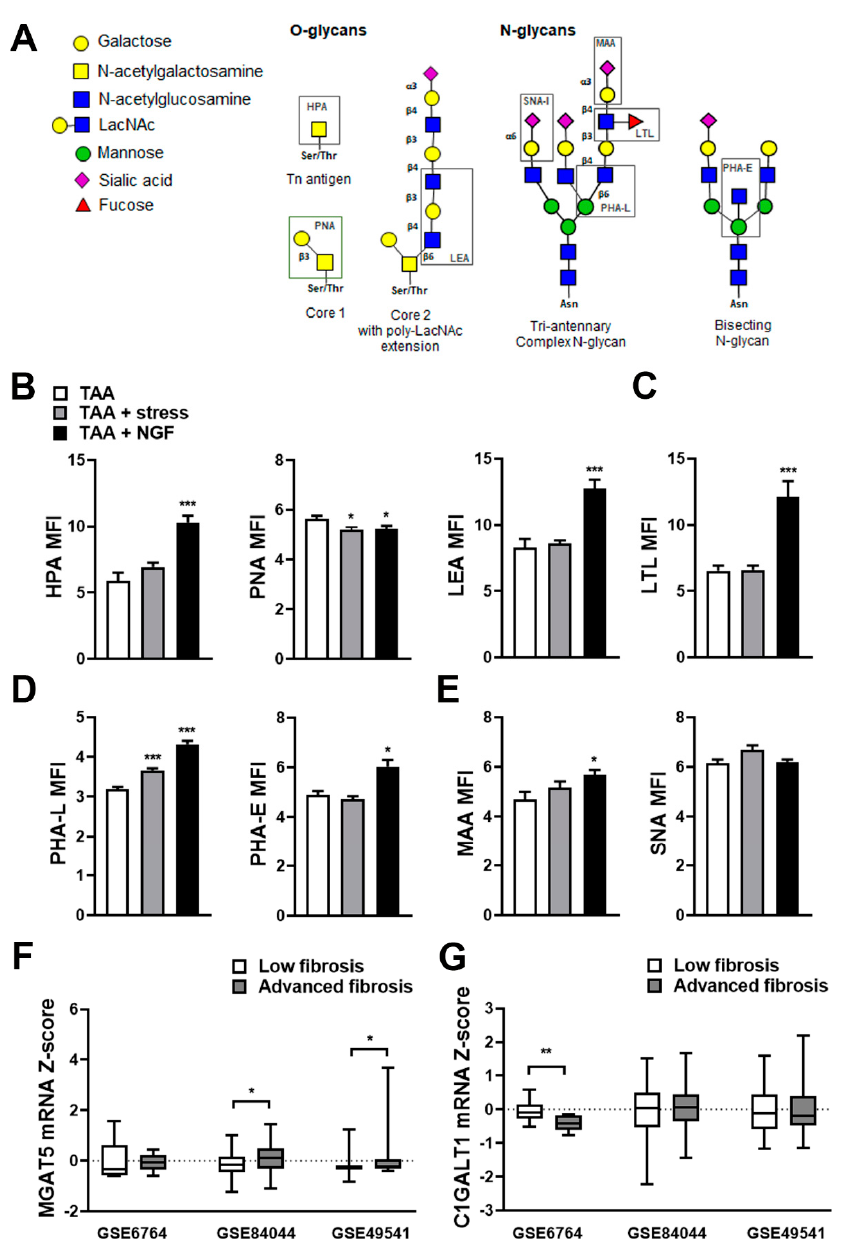
Figure 5. ( A ) For an analysis of the glycophenotype, lectins were used to detect different types of glycosylation. O-glycan structures were recognized by Helix pomatia agglutinin (HPA; Tn-antigen) and Arachis hypogaea lectin (PNA; core 1). Lycopersicon esculentum lectin (LEA) recognizes polyLAcNac sequences. Phaseolus vulgaris lectin (PHA-L) recognizes β 1-6GlcNAc-branched complex N-glycans and Phaseolus vulgaris lectin E subunit (PHA-E) identifies glycans with a bisecting modification. Fucosylation was determined by Lotus tetragonolobus lectin (LTL) and finally sialyation was determined using the Maackia amurensis lectin (MAA) and Sambucus nigra agglutinin (SNA-I) which bind to α 2,3- and α 2,6-linked sialic acid, respectively. Quantification of O-glycan ( B ), fucosylation ( C ), N-glycosylation ( D ), or sialylated glycan ( E ) was performed on liver sections of mice with fibrosis (TAA), fibrosis and stress (TAA + stress), and fibrosis and NGF administration (TAA + NGF). Mean fluorescence intensity (MFI) ± S.E.M is shown. * p < 0.05 and *** p < 0.001 vs. TAA (Kruskal–Wallis test). Expression of MGAT5 ( F ) and C1GALT1 ( G ) in patients with fibrosis due to HCV (GSE6764), HBV (GSE84044), or NAFLD (GSE49541). * p < 0.05 and ** p < 0.01 (Mann–Whitney